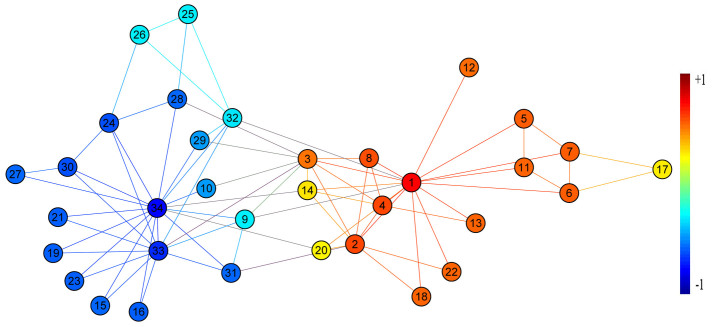
Application of the IM criterion to Zachary's karate club network.Agent 1 and agent 34 are two competitors. A normal agent is colored red (blue) if the influence difference fk1 − fk34 > 0 (fk1 − fk34 < 0). We dye all the nodes according to their normalized difference. The darker the color the larger the absolute difference is.